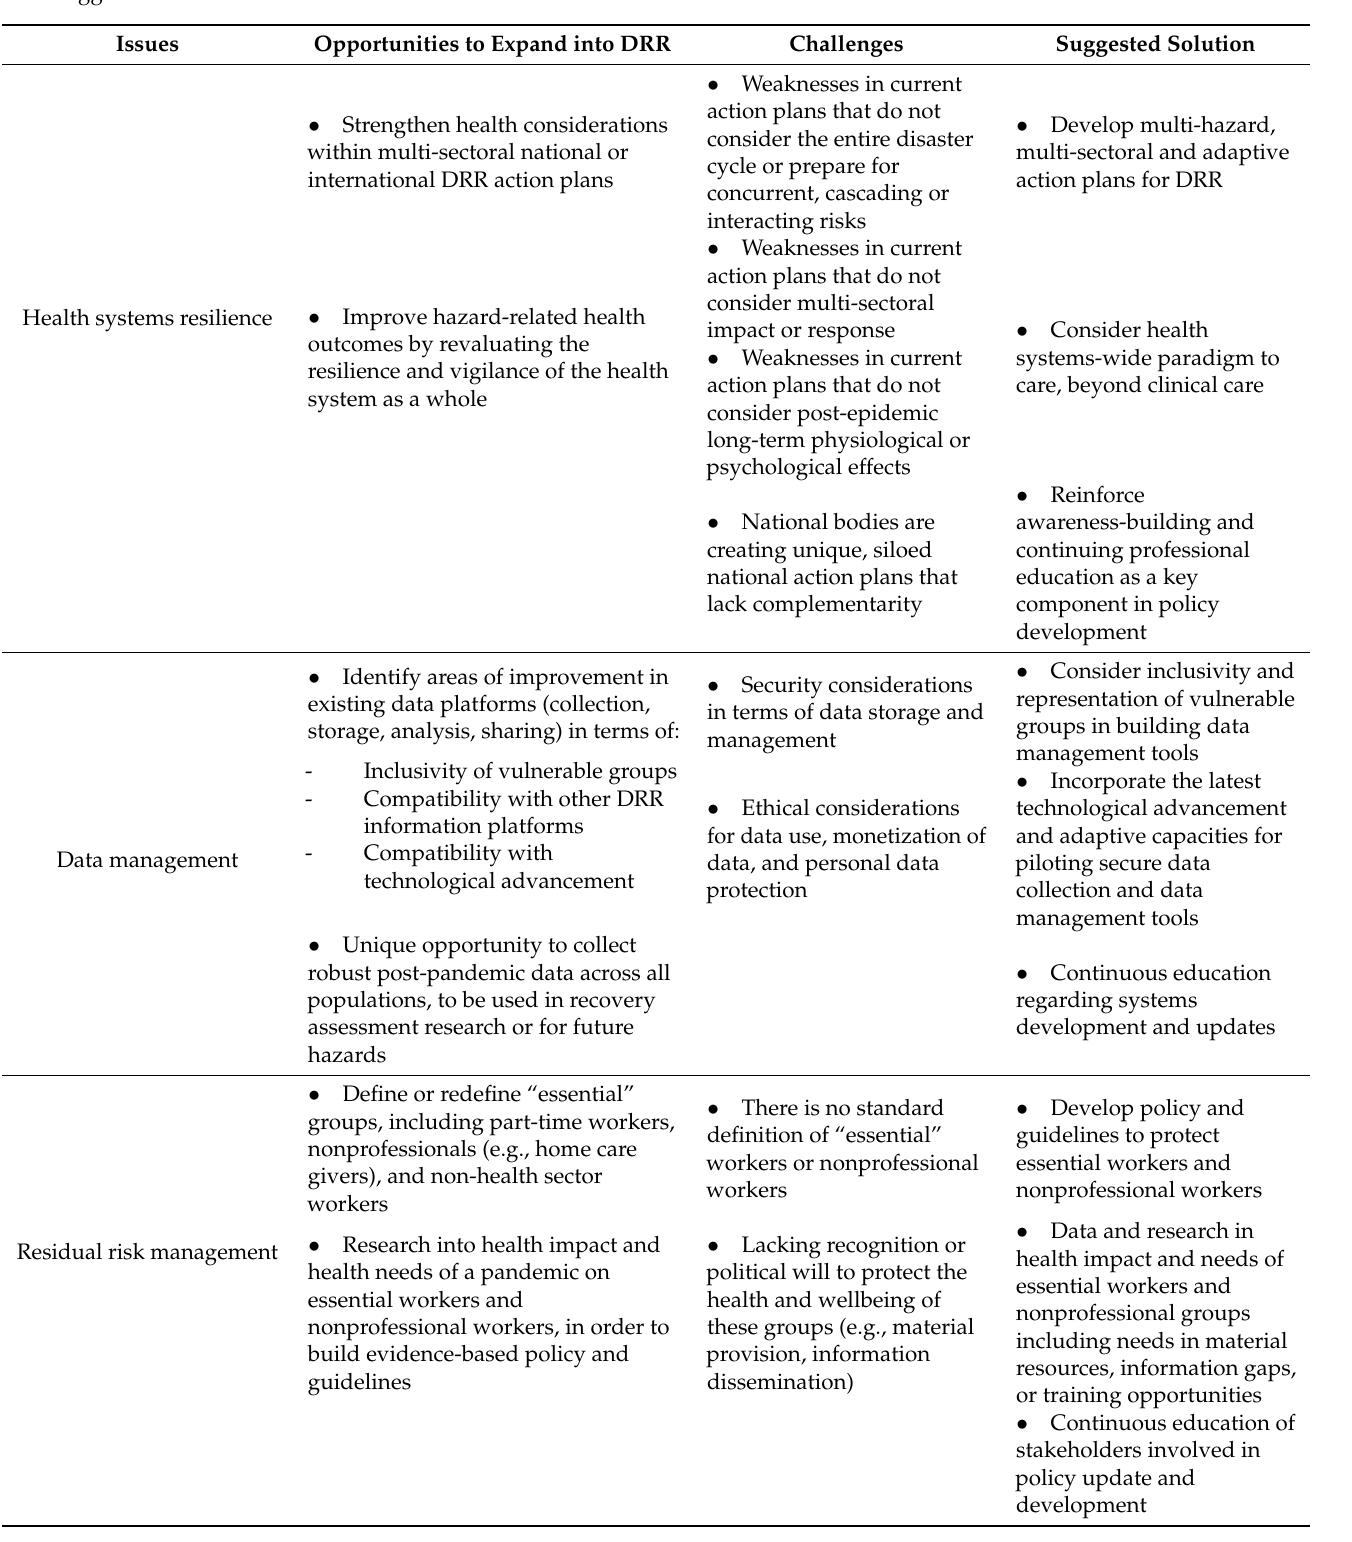
Table 1. Opportunities for different areas to expand into and impact disaster risk reduction (DRR), related challenges and suggested